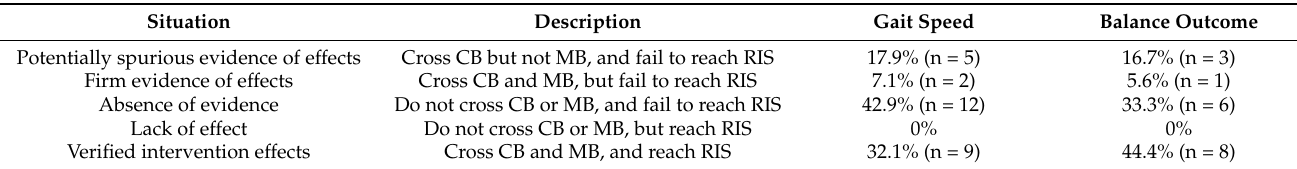
Table 1. The TSA results for the included studies.